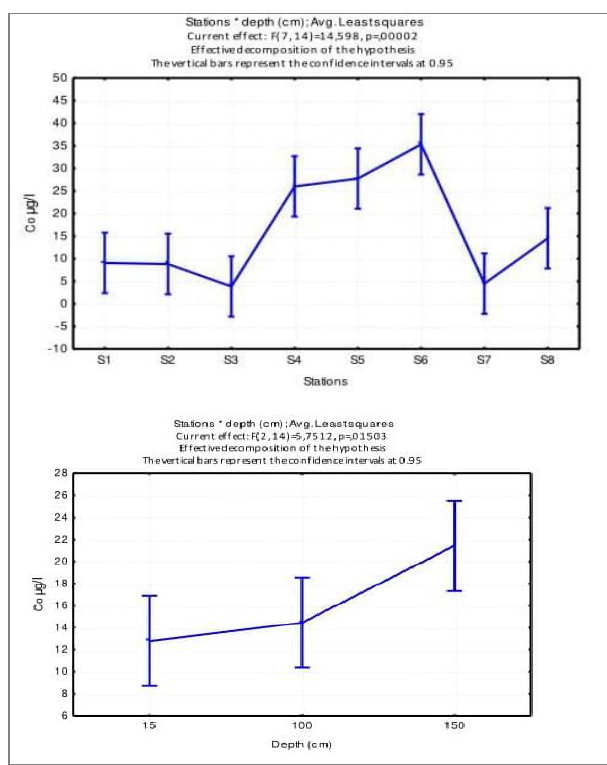
Figure 14 Spatial variation of Co in μg/l in the Reghaia lake.